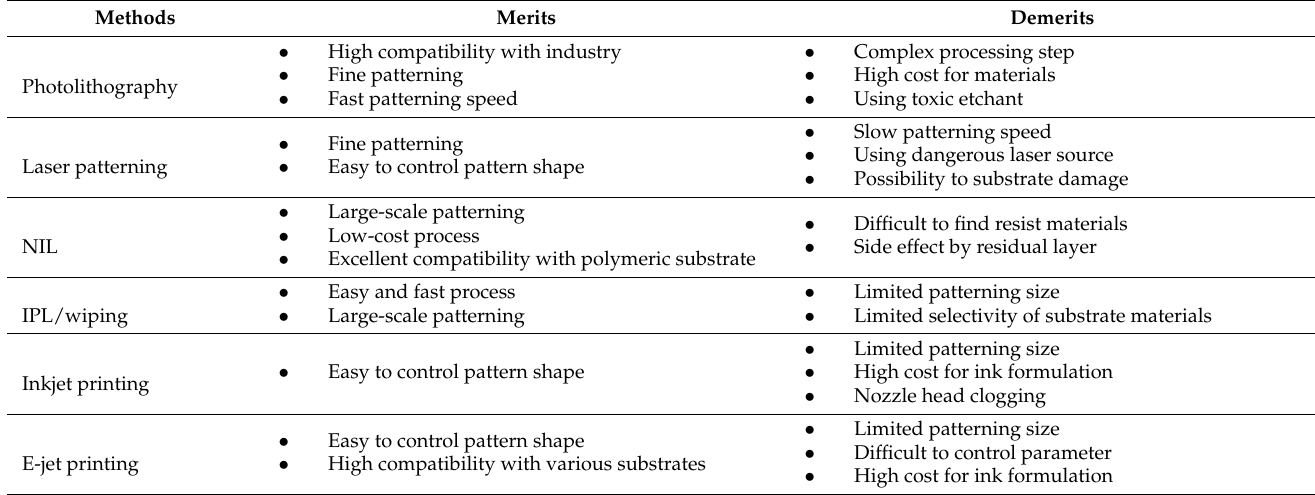
Table 1. A summary of the various types of patterning